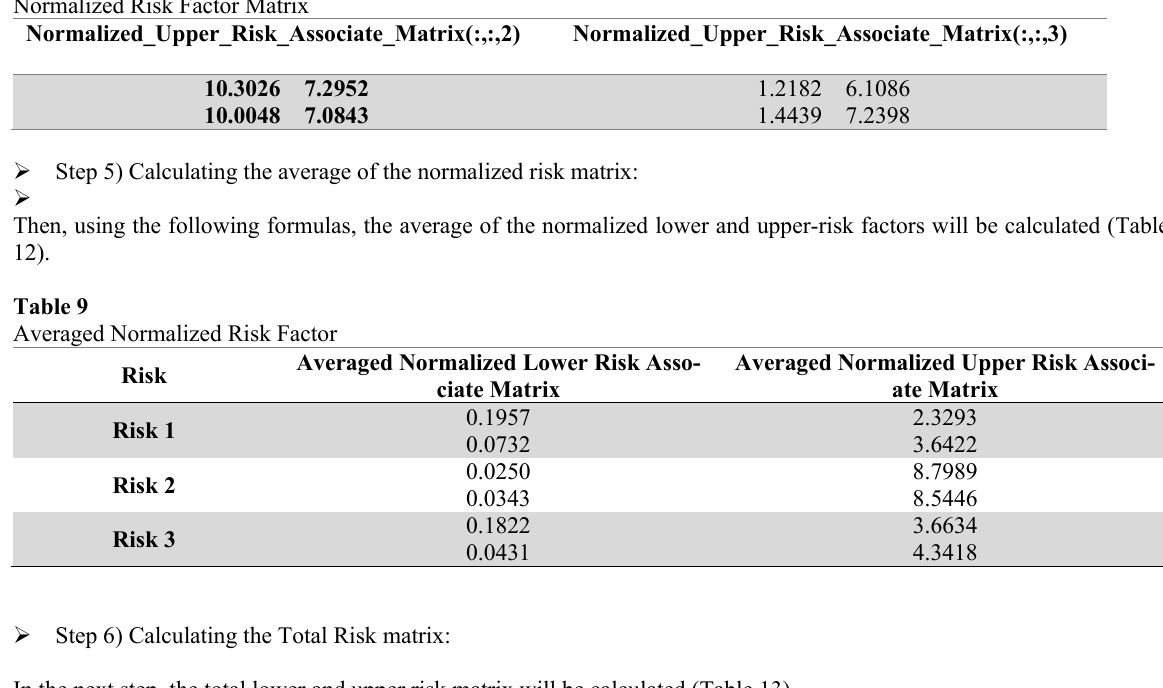
Normalized Risk Factor Matrix